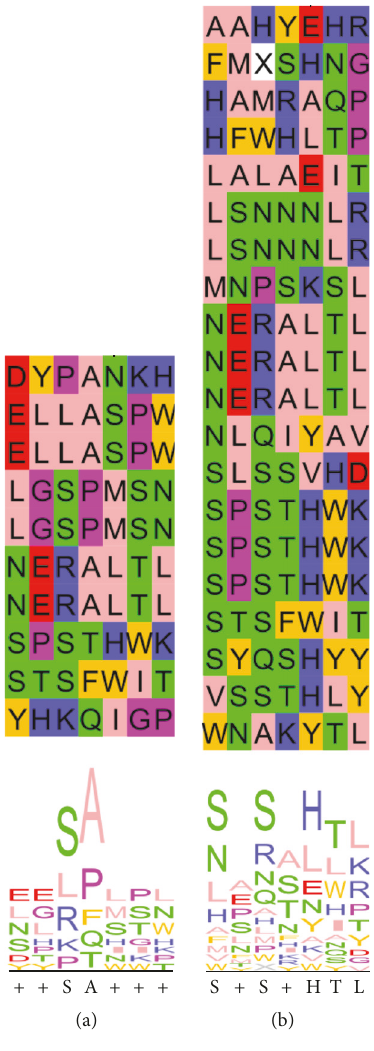
Figure 4: Peptide sequences resulting from binder phages confirmed by phage-ELISA. (a) Peptides resulting from panning on full DENV2 envelope. (b) Peptides resulting from panning on recombinant DENV2 envelope domain III. Sequence logos and consensus sequence, as calculated using JalView, are depicted below each list of peptides. Coloring of residues and sequence logos as per Zappo scheme, where residues are colored according to their physicochemical properties as follows: pink, aliphatic/hydrophobic; orange, aromatic; red, positive; green, negative; blue, hydrophilic; magenta, proline/glycine; and yellow,